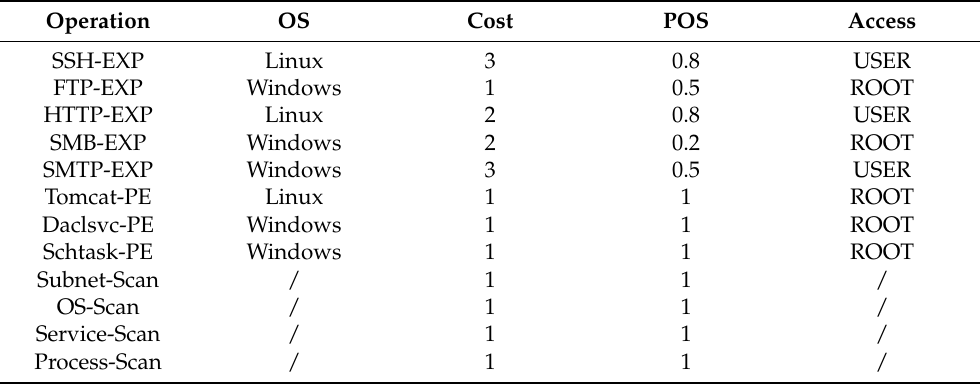
Table 2. Operation list of the agent in experimental scenario 1. Eight EXP and PE operations are associated with the services and processes running in computers. Four kinds of scan operations can be used for an agent to obtain knowledge of the hosts’